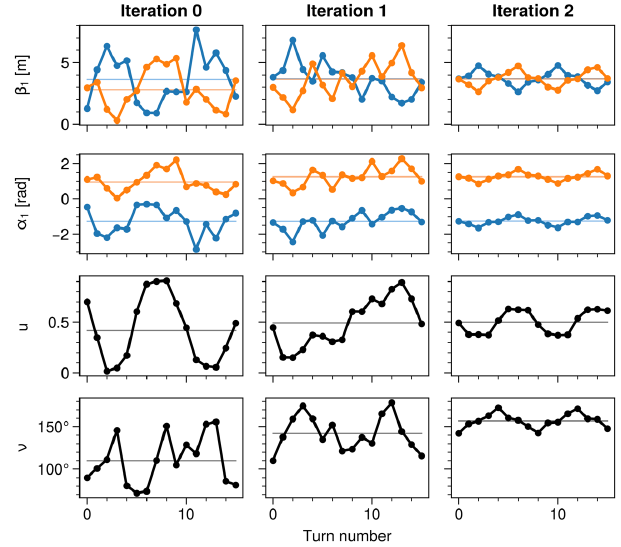
FIG. 6. Turn-by-turn oscillations of the beam parameters after the first few iterations of the matching routine. The custom update method is used. The faint horizontal lines give the average of the oscillations. Blue (orange) corresponds to the x ( y )